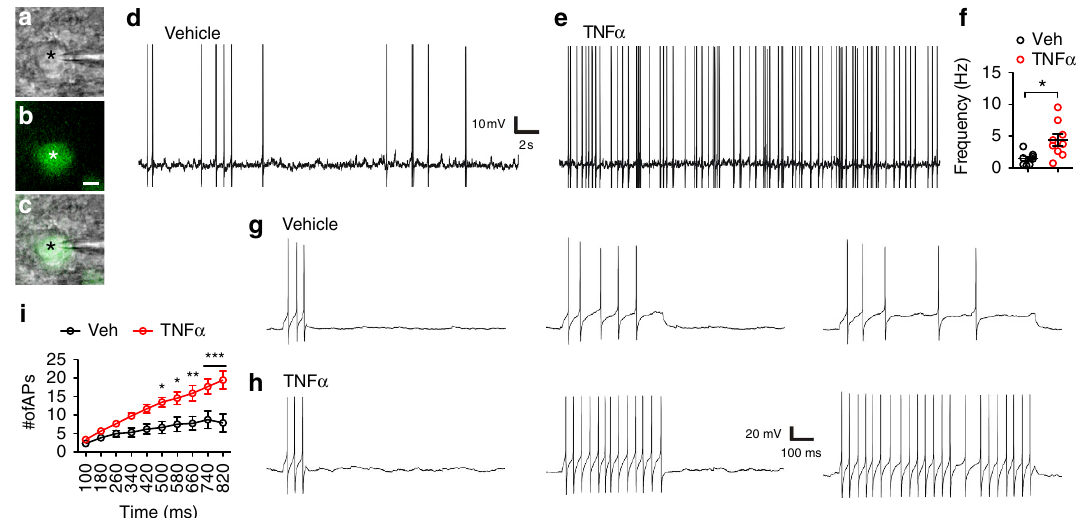
Figure 3 | TNF a increases neuronal firing activity and evokes excitability of arcuate nucleus POMC neurons. ( a – c ) Representative example of a patched POMC eGFP neuron (asterisk) observed under DIC ( a ) and fluorescence ( b ) illumination ( a , b superimposed in c ). ( d , e ) Representative traces depicting spontaneous firing activity of two POMC eGFP neurons that were pre-incubated either in vehicle (aCSF) ( d ) or in TNF a ( e , 1 m gml (cid:3) 1 ). The mean ongoing firing frequency of POMC eGFP neurons in each condition is summarized in f ( n ¼ 8 for vehicle and 9 for TNF a , P ¼ 0.012). ( g – i ) Representative traces of evoked firing potentials (APs) in response to depolarizing steps (25pA) of increasing durations (100–820ms) in vehicle ( g ) and in TNF a ( h ) ( n ¼ 9 for vehicle and 10 for TNF a ), ( i ) there was a significant interaction between time and drug on the APs ( F (9,153) ¼ 8.867, P o 0.001), and there were also significant effects of time or drug on APs ( F (1,15) ¼ 41.27, P o 0.001 for time; F (1,15) ¼ 9.235, P ¼ 0.008 for drug). Scale bar in b , 20 m m. * P o 0.05, ** P o 0.01, *** P o 0.001, for comparison between vehicle and TNF a groups. Data are presented as means ± s.e.m. P values were analysed by Student’s t -test ( f ) or two-way repeated measures ANOVA followed by post hoc t -test ( i